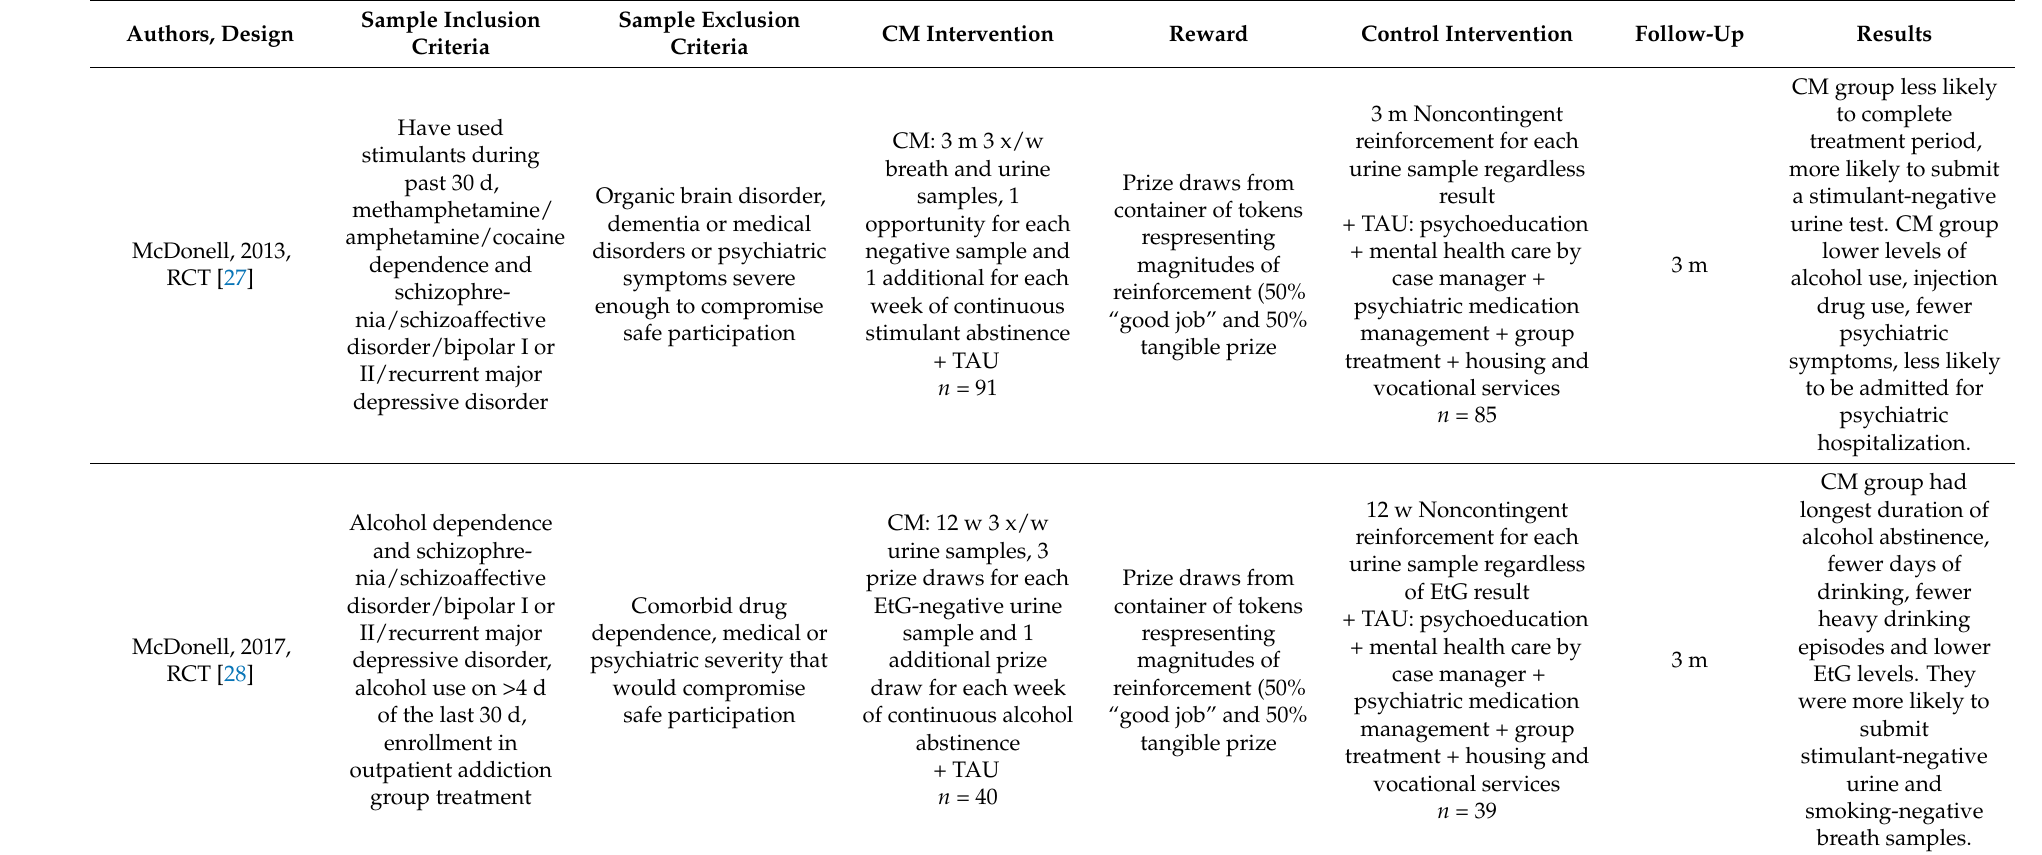
Table 2. Overview of